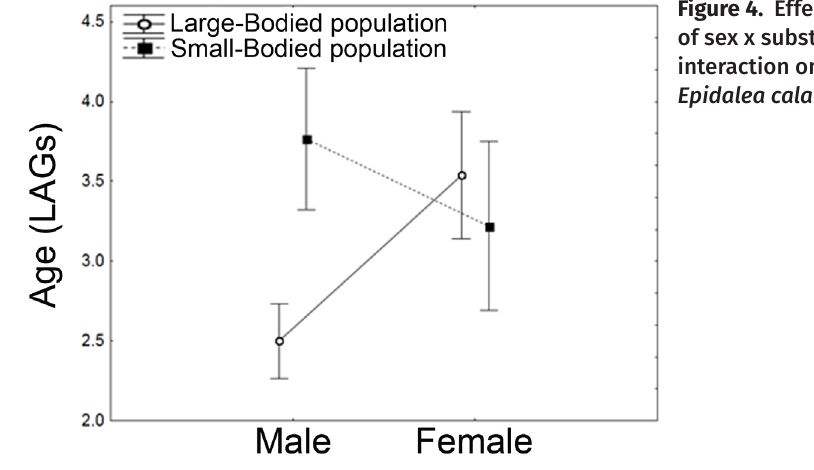
Figure 4. Effects of sex x substrate interaction on age in Epidalea calamita